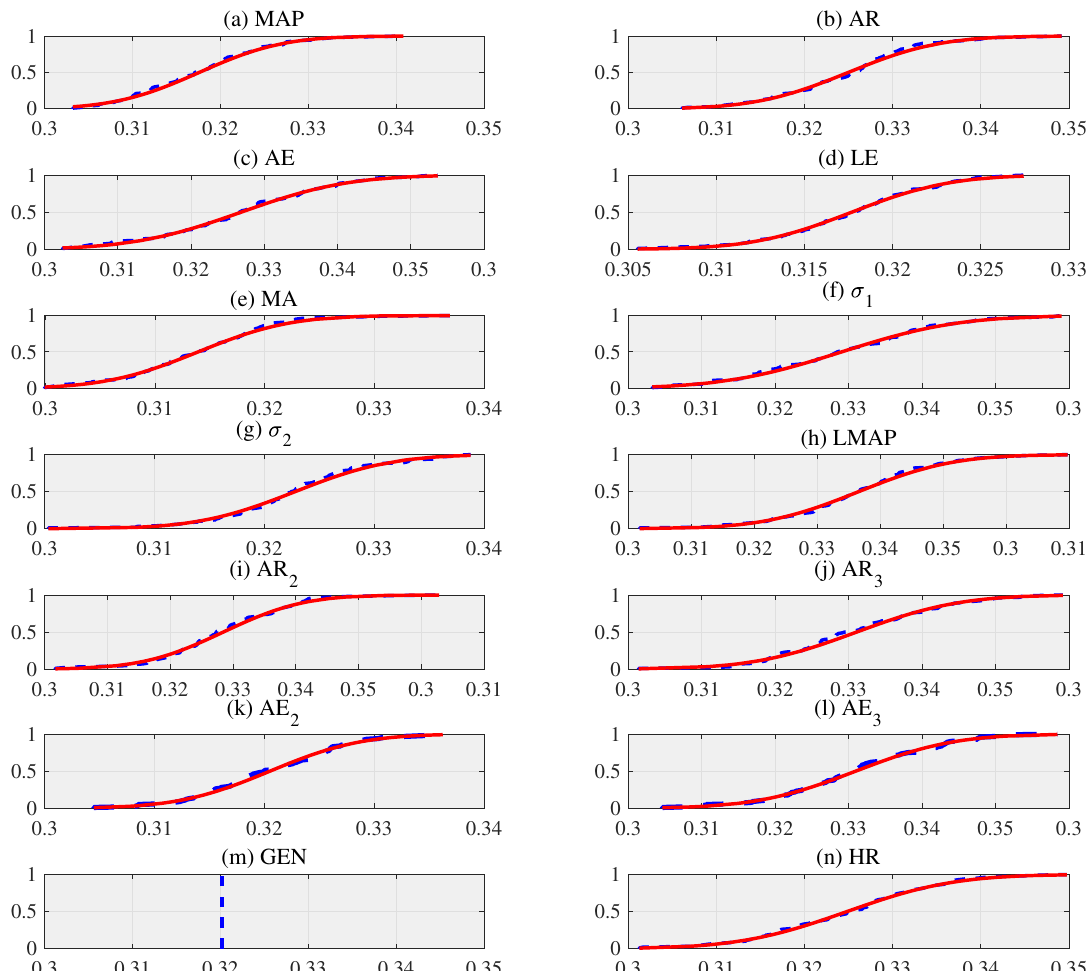
Figure 2. The cumulative distribution function (CDF) of artificial input data using the bootstrap technique with replication size ( N = 100), where artificial input data are examples acquired from a volunteer with 5 samples